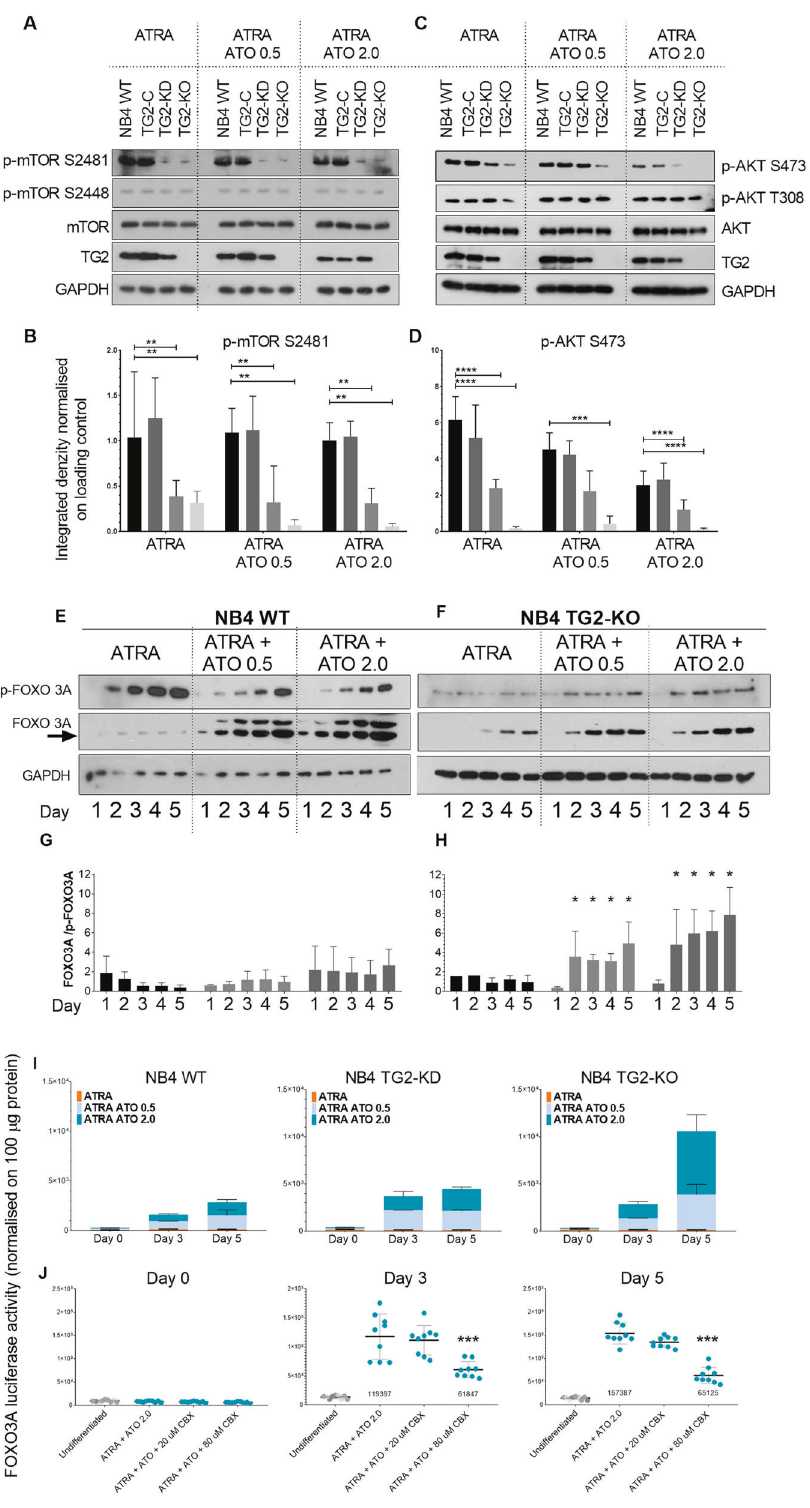
fi rst column) via the AKT S473 phosphorylated form (Fig. 3C, D, fi rst block). In the presence of ATO and the absence of TG2, AKT S473 remained unphosphorylated (Fig. 3C, D, third blocks) and was associated with a signi fi cant increase in FOXO3 transcriptional activity (Fig. 3I, third column). Treatment with Carbenoxolone (CBX), a potential FOXO3 inhibitor, reduced the luciferase